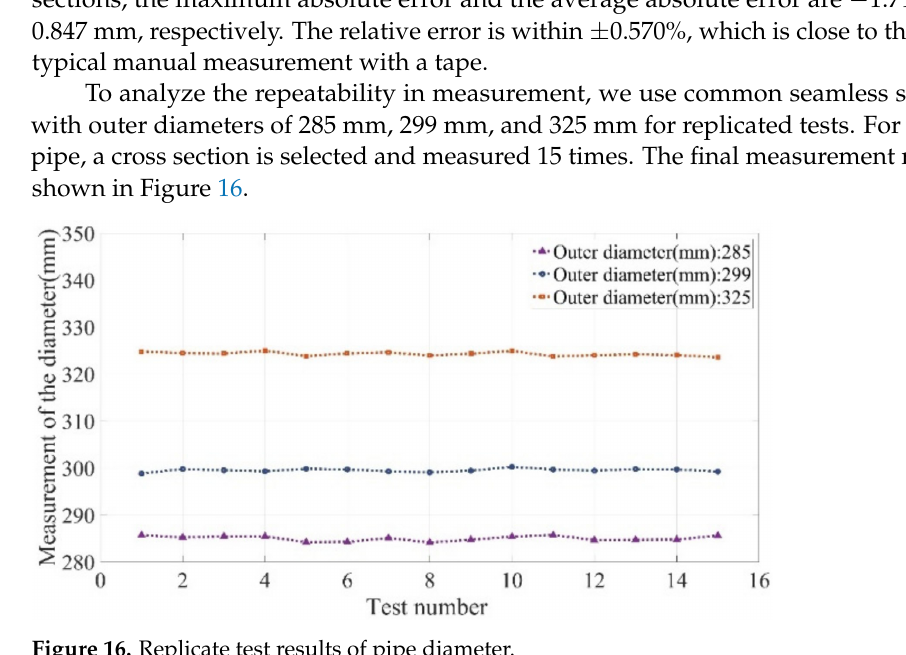
Figure 16. Replicate test results of pipe